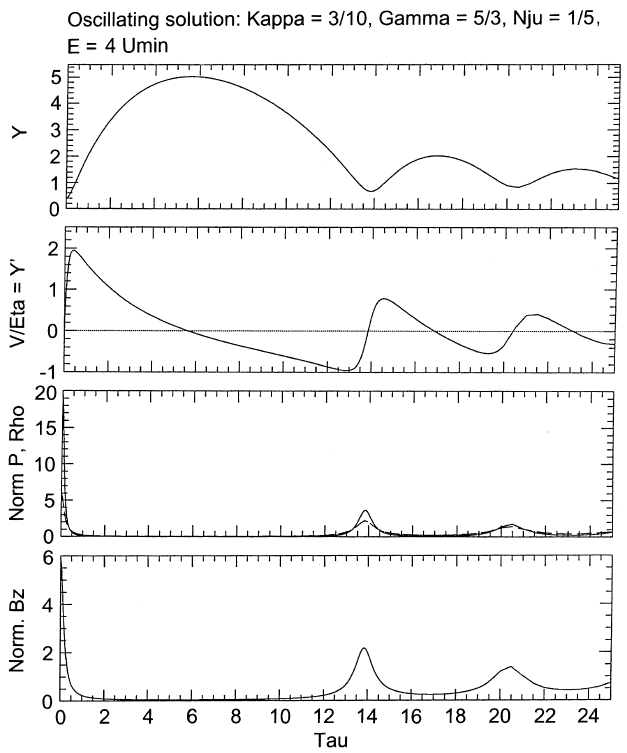
Fig. 7. A comparison of the damped oscillations of two flux ropes with and without plasma pressure. The dotted line refers to a zero-beta configuration, while the solid line refers to (cid:106) (cid:136) 0 : 8 : The drag coefficient, (cid:109) (cid:3) (cid:136) 0 : 2 is the same for both